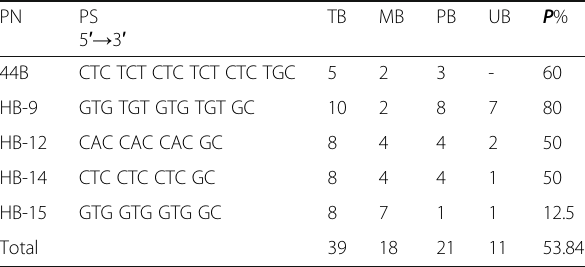
Table 4 Code and sequences of ISSR primers used in molecular characterization of identifying the five Coleus